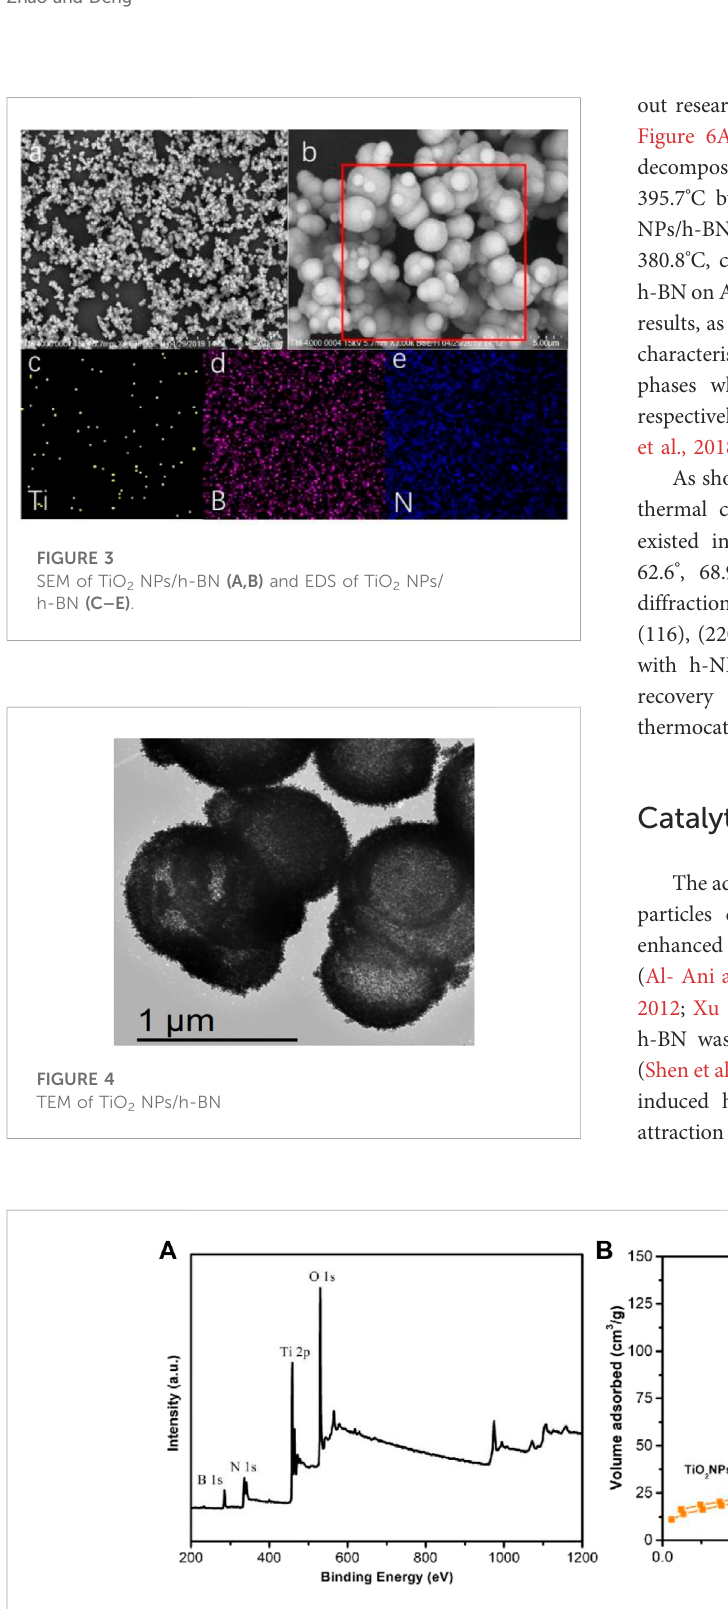
FIGURE 5 (A) XPS of TiO 2 NPs/h-BN. (B) N2 adsorption/desorption isotherms of TiO 2